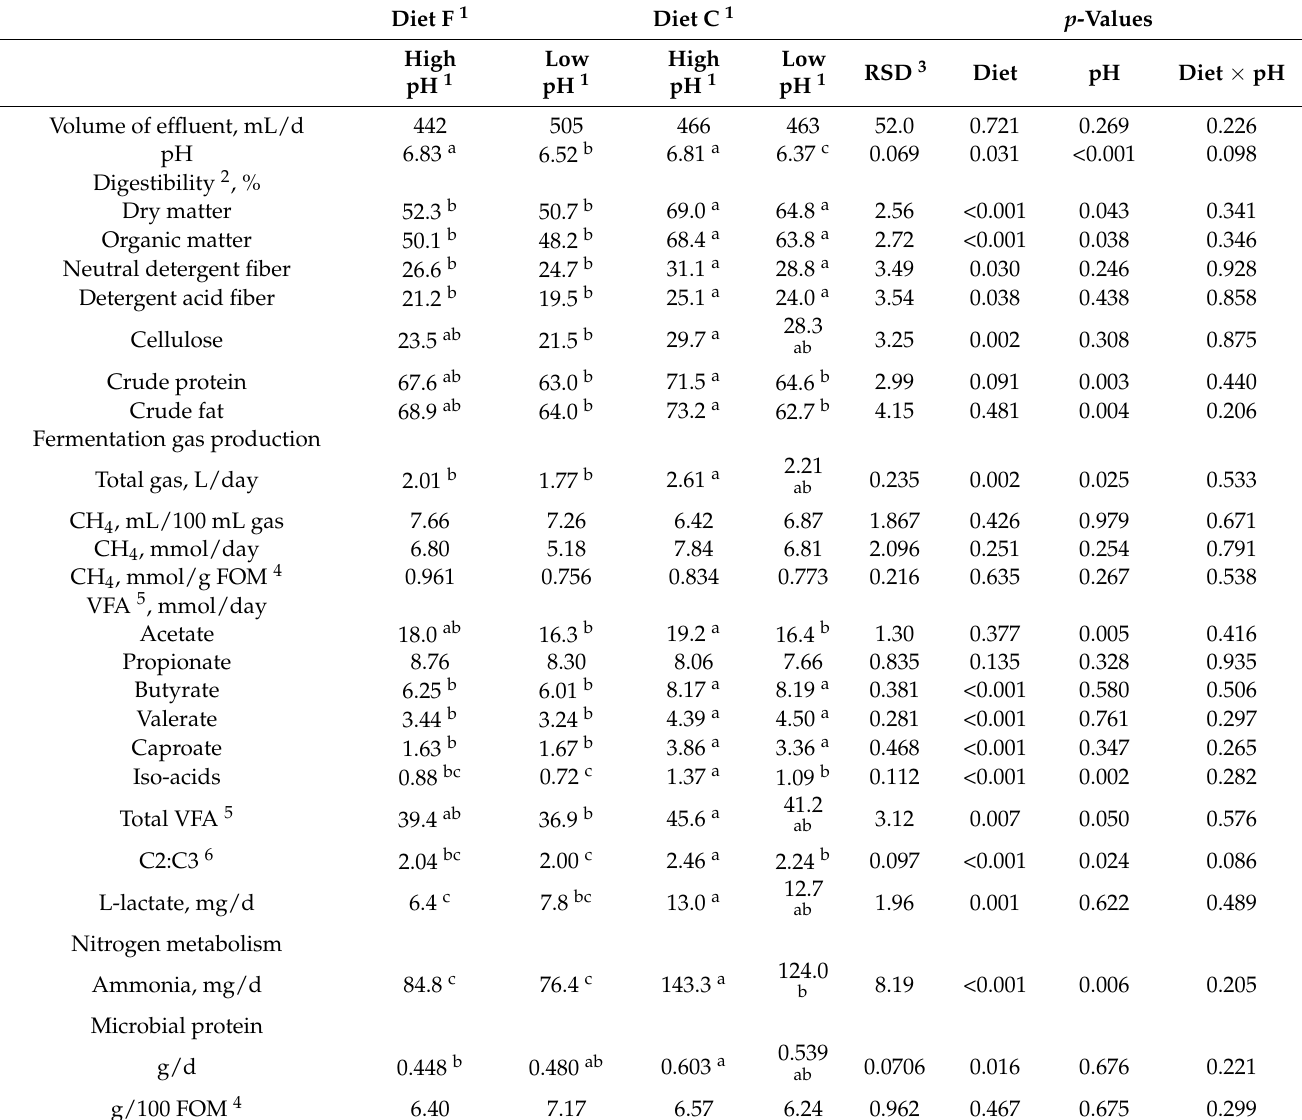
Table 3. Effect of diet and pH in the medium (high or low) on rumen fermentation in continuous